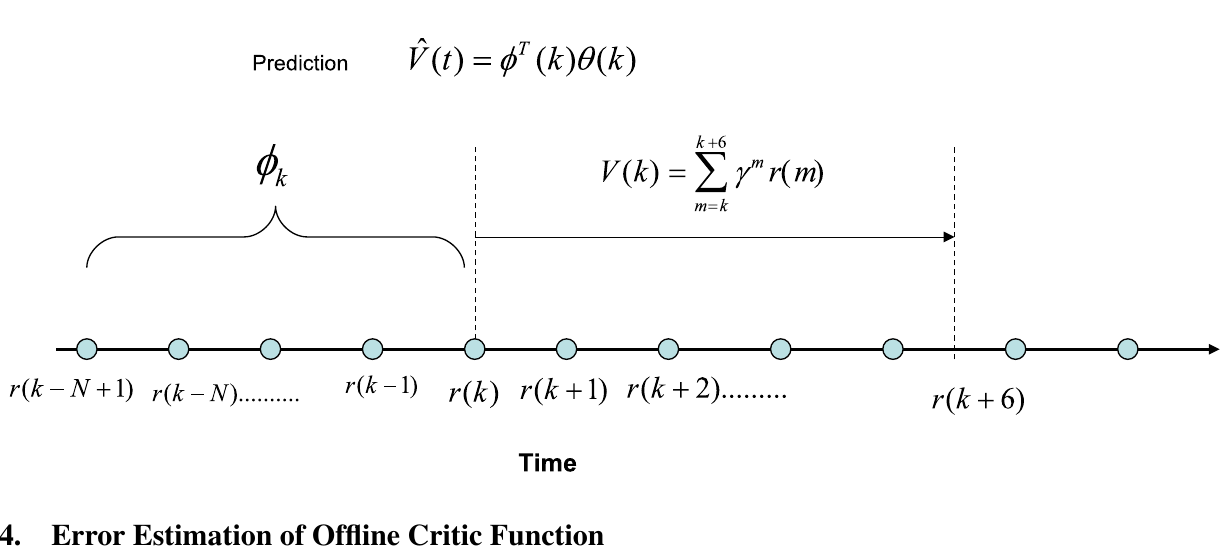
Figure 4. The structure of the polynomial critic